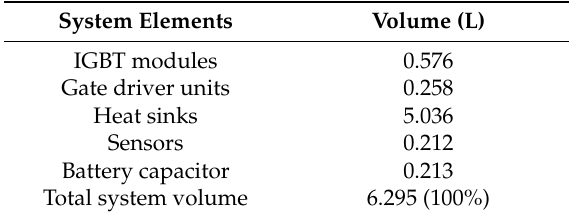
Table 1. Volume of the components of the inverter and on-board charger (OBC) in a conventional hybrid electric vehicle (HEV).